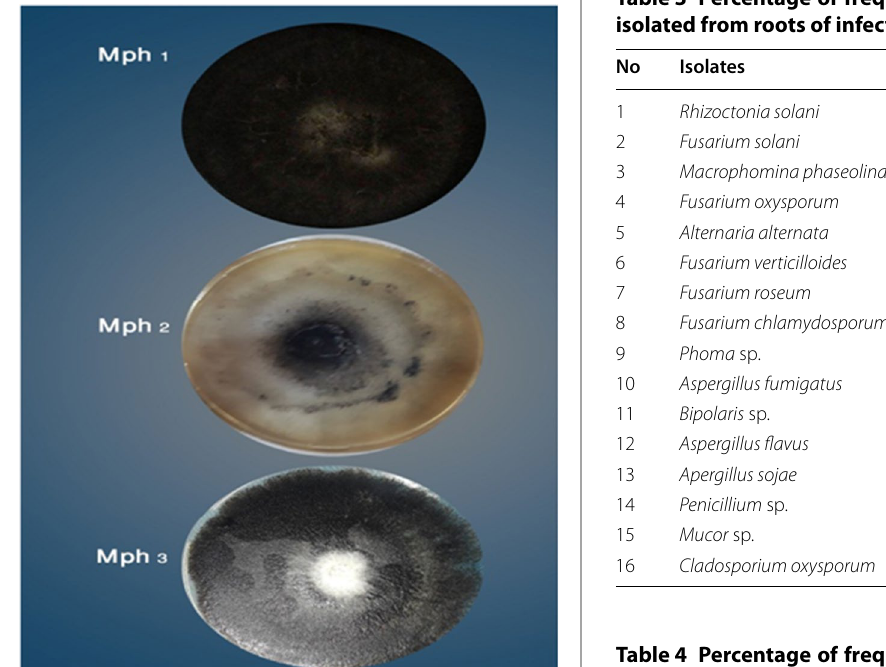
Table 4 Percentage of frequency and appearance of